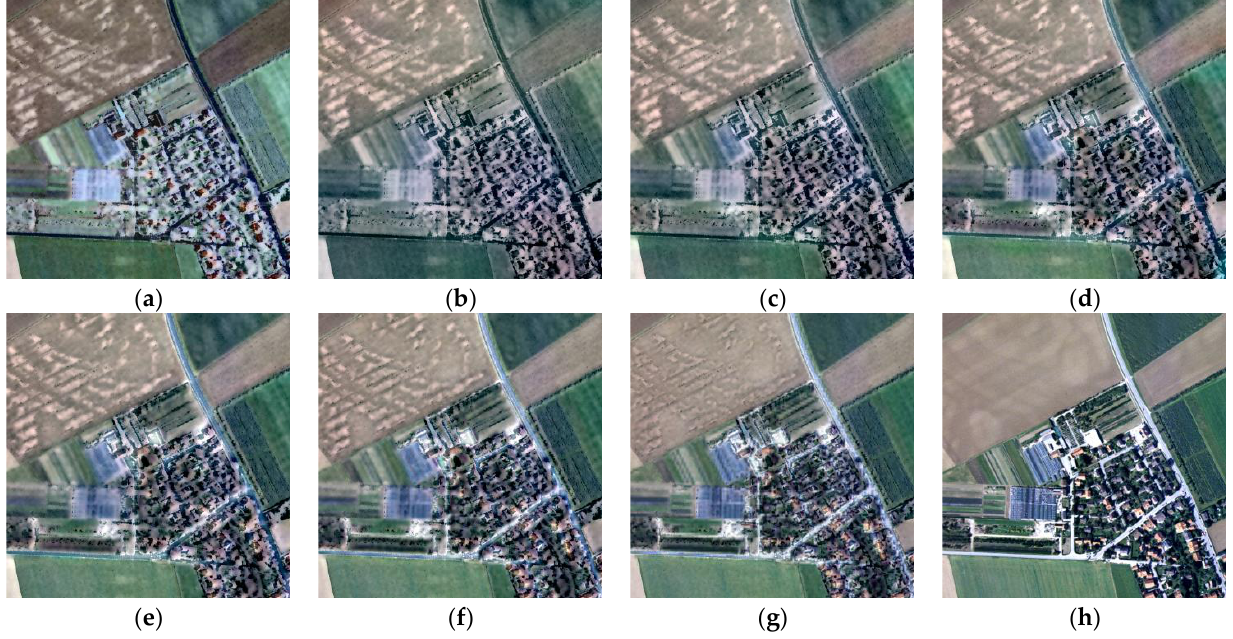
Figure 10. Fusion results of adjustability experiment in area 2. ( a ) IHS fusion; ( b ) LPSR-5; ( c ) LPSR-4; ( d ) LPSR-3; ( e ) LPSR-2; ( f ) LPSR-1; ( g ) LP-based fusion; ( h ) original HR multispectral image.